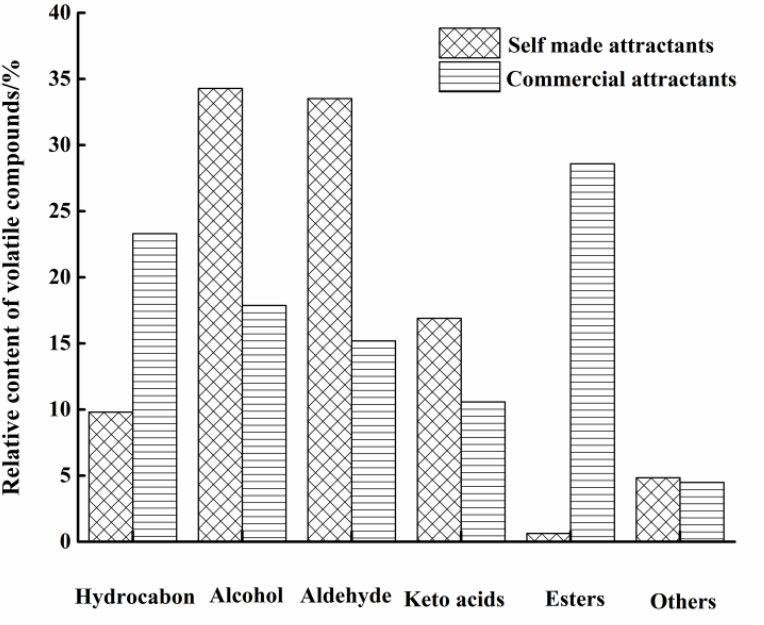
Figure 2. Relative content of volatile compounds in self-made and commercial attractants.